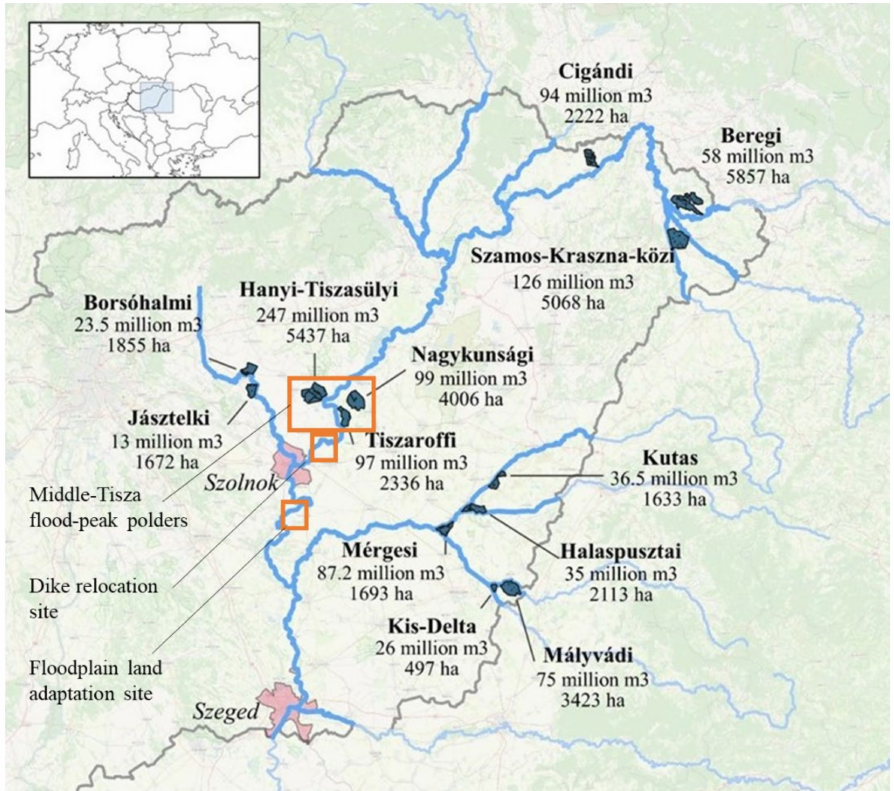
Figure 1. The middle section of the Tisza River. Legend: Map shows the flood polder system of the area and highlights the location of the study areas. Adapted from Ref.